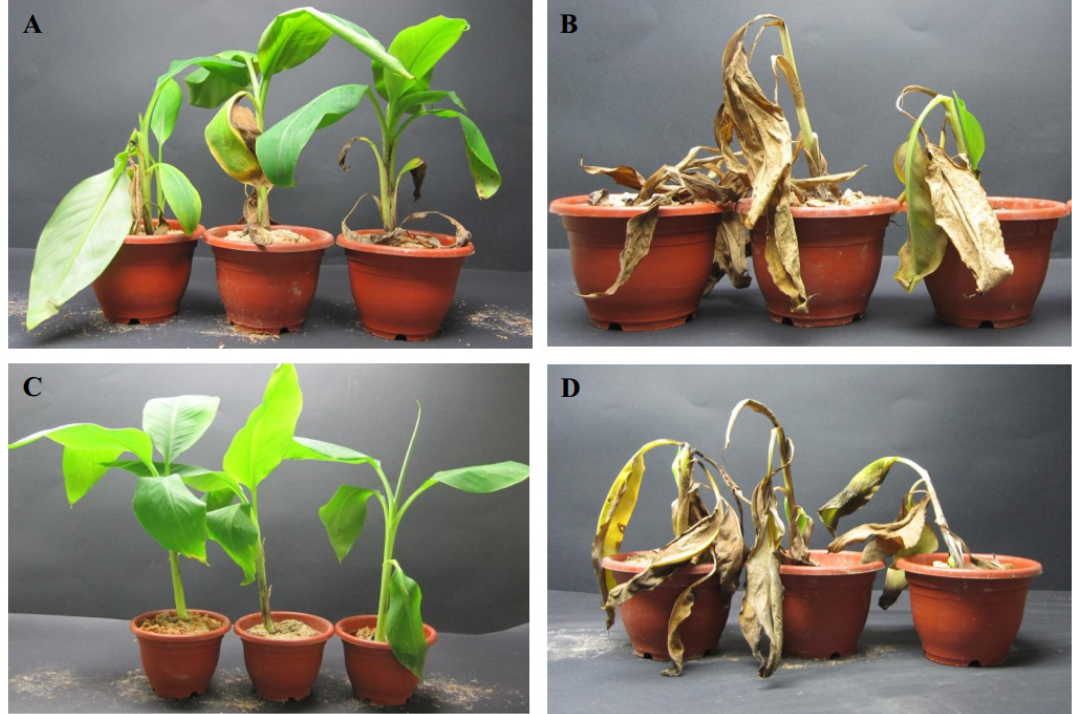
Figure 8. Inoculation results of pgc4 gene knock-out mutants. ( A ): Foc4 Δ pgc4 ; ( B ): Foc4; ( C ): water control; ( D ): Foc4 Δ pgc4 + pgc4 .